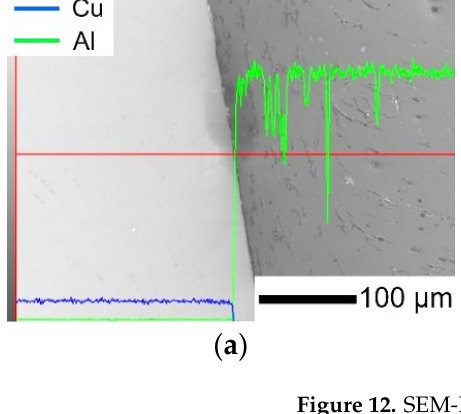
Figure 12. SEM-EDX analysis of joint boundary (left: C1100, right: A6061): ( a ) SEM image and line scan result; ( b ) Magnified view of central part.